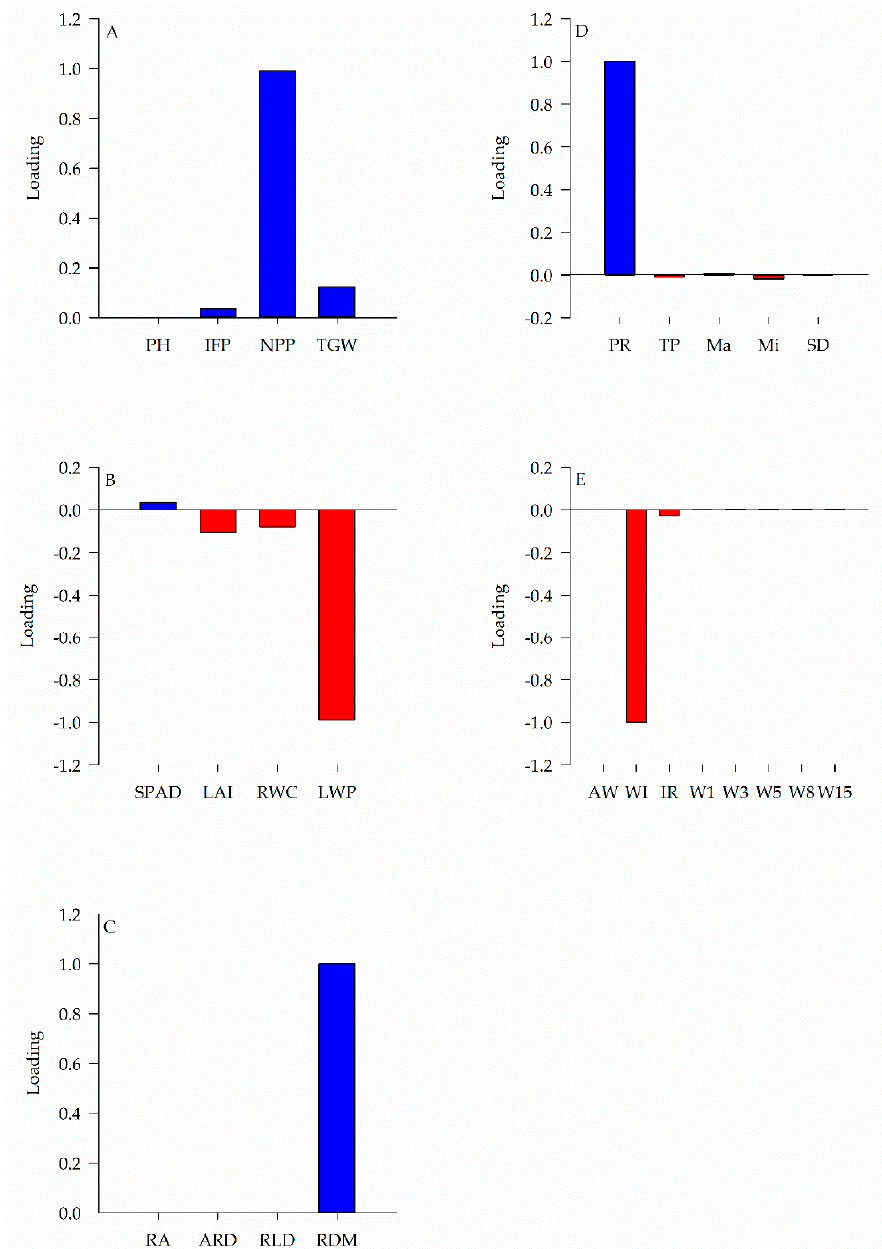
Figure 1. Loadings of variable in yield components ( A ), physiological traits ( B ), root development ( C ), soil physic ( D ), and soil water ( E ). PH: plant height; IFP: insertion of the first pod; NPP: number of pods per plant; TGW: thousand grain weight; SPAD: index SPAD; LAI: leaf area index; RWC: leaf relative water content; LWP: leaf water potential; RA: root area; ARD: average root di- ameter; RLD: root length density; RDM: root dry matter; PR: soil penetration resistance; TP: soil W3: water stored three days after rain; W5: water stored five days after rain; W8: water stored eight days after rain; W15: water stored 15 days after rain. Blue color indicates positive loading variable; and the red color indicates a negative loading variable.